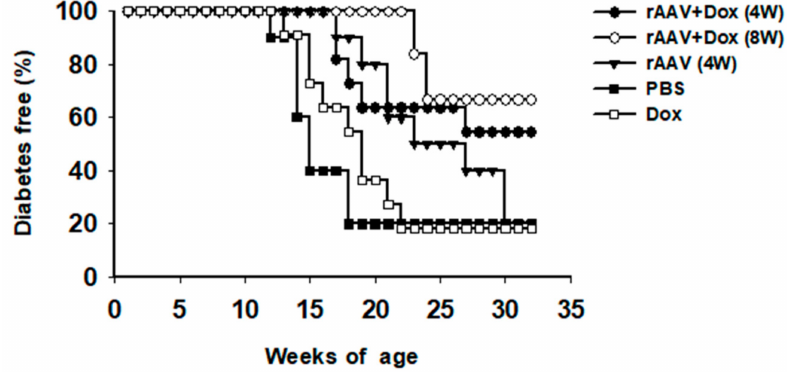
Figure 5. Life table analysis for diabetes development. All animals were monitored weekly for hyperglycemia. If two consecutive ( > 24 h apart) non-fasting blood glucose levels ( > 240 mg / dL) were recorded, the animal was defined as diabetic and was removed from the group. * p < 0.05, rAAV + Dox (4 W) or rAAV + Dox (8 W) vs. PBS or